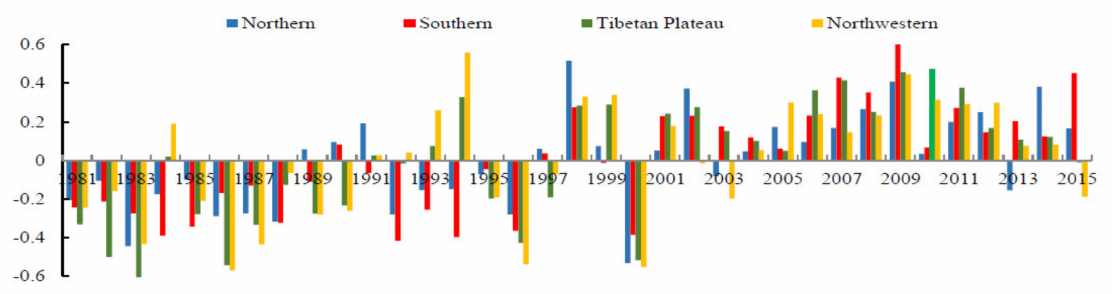
Figure 4. Interannual changes in spring AVCI in different geographic areas.